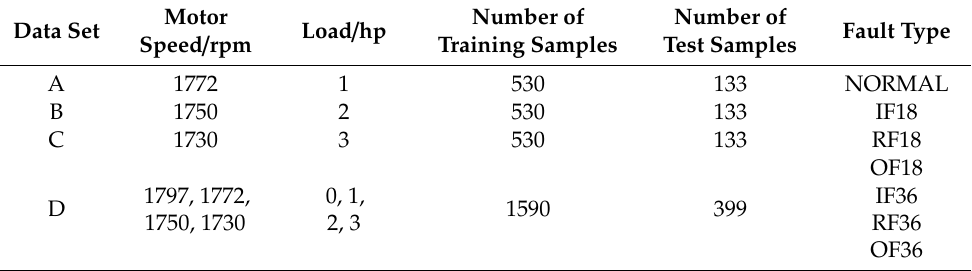
Table 3. Training set and Test set based on 10-fold cross-validation method of CWRU.